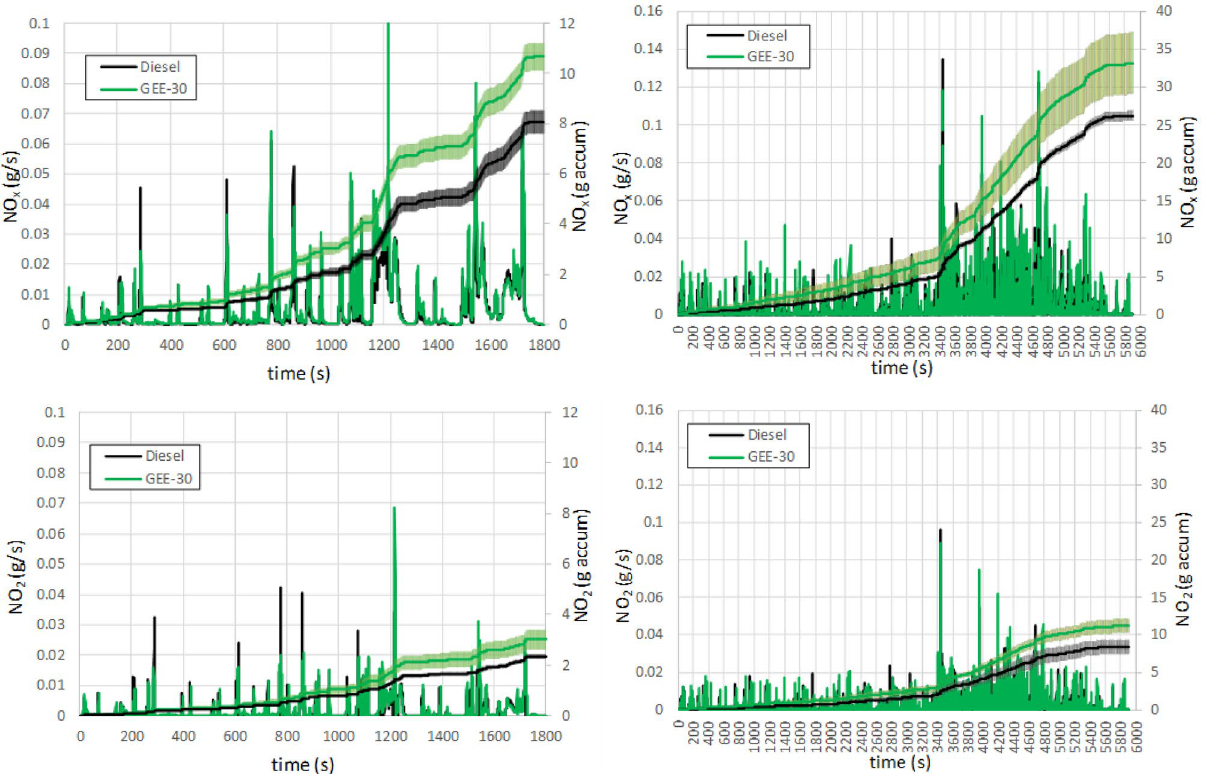
Figure 9. Instantaneous and accumulated NO x (above) and NO 2 (below) emissions along WLTC (left) and along RDE